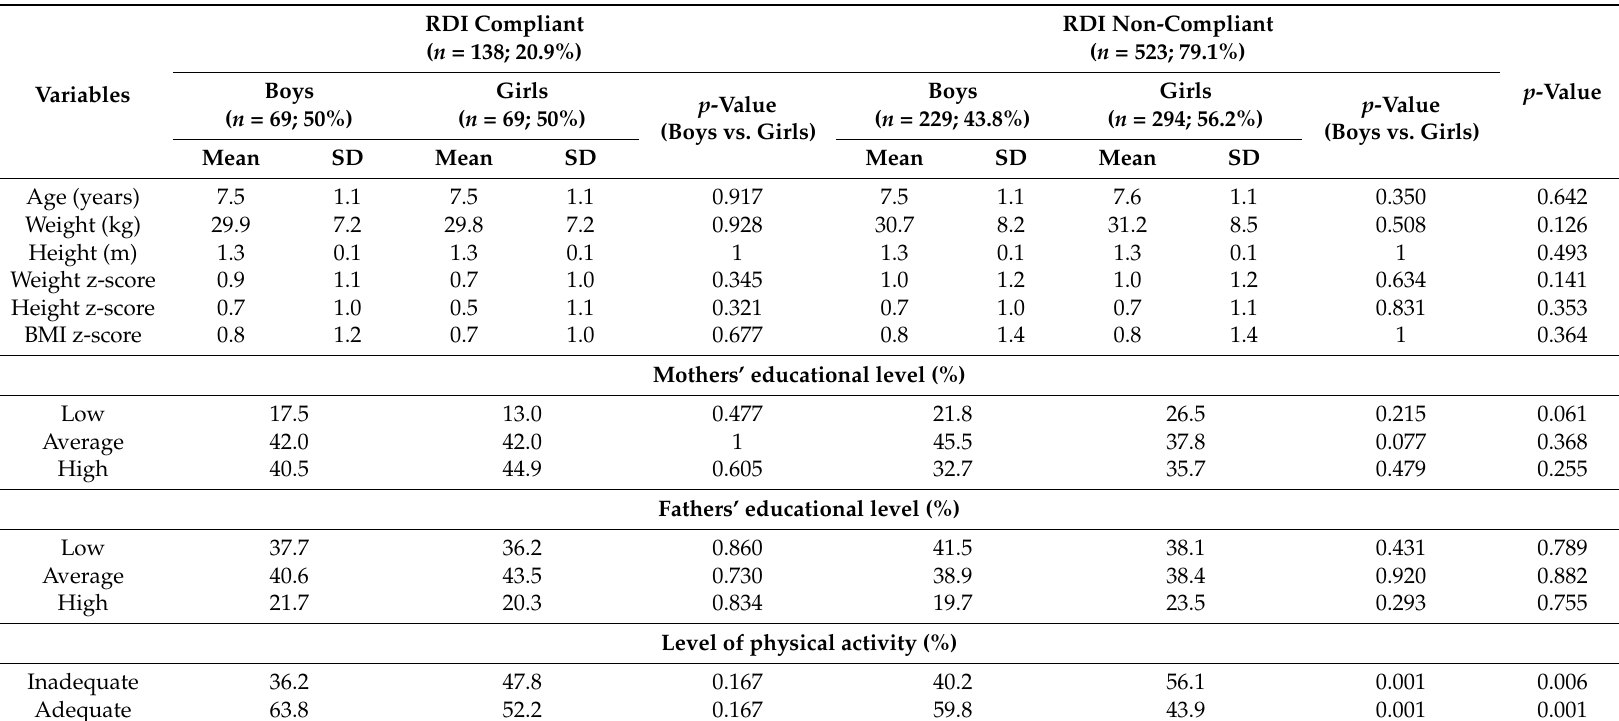
Table 1. Anthropometric characteristics of schoolchildren in relation to iodine